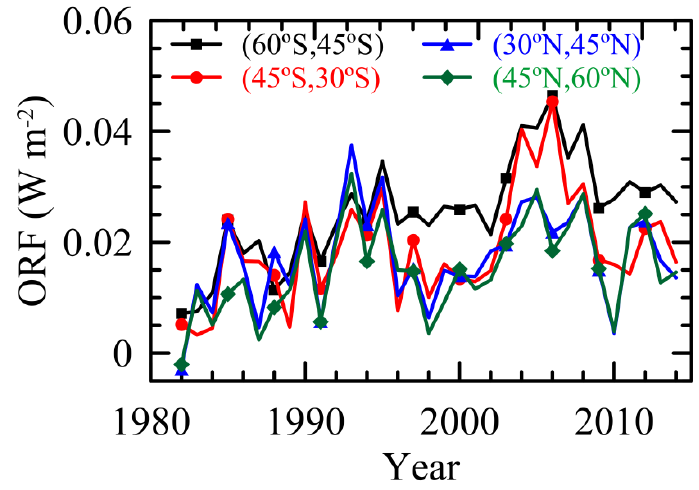
Figure 2. Evolution of yearly ORF in the UV-B range at four latitudinal bands.